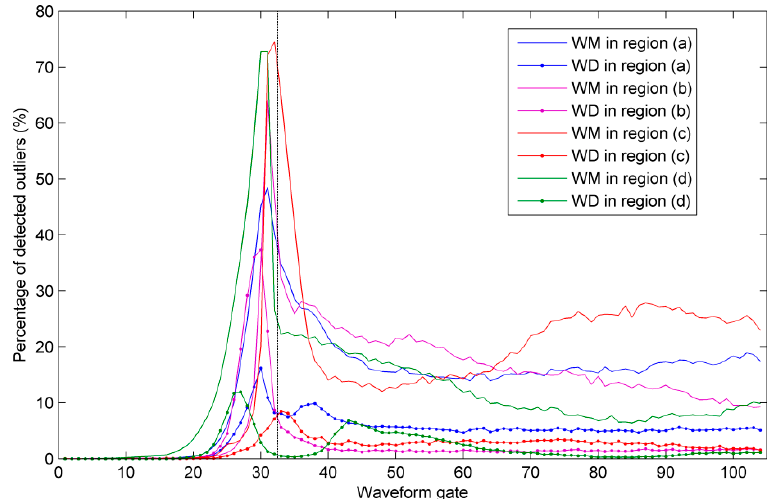
Figure 9. Percentage of detected outliers at each sampling gate in the four study regions for the WM (solid curves) and for the WD (solid curve with dot). The black dashed line shows the location of the nominal tracking gate.